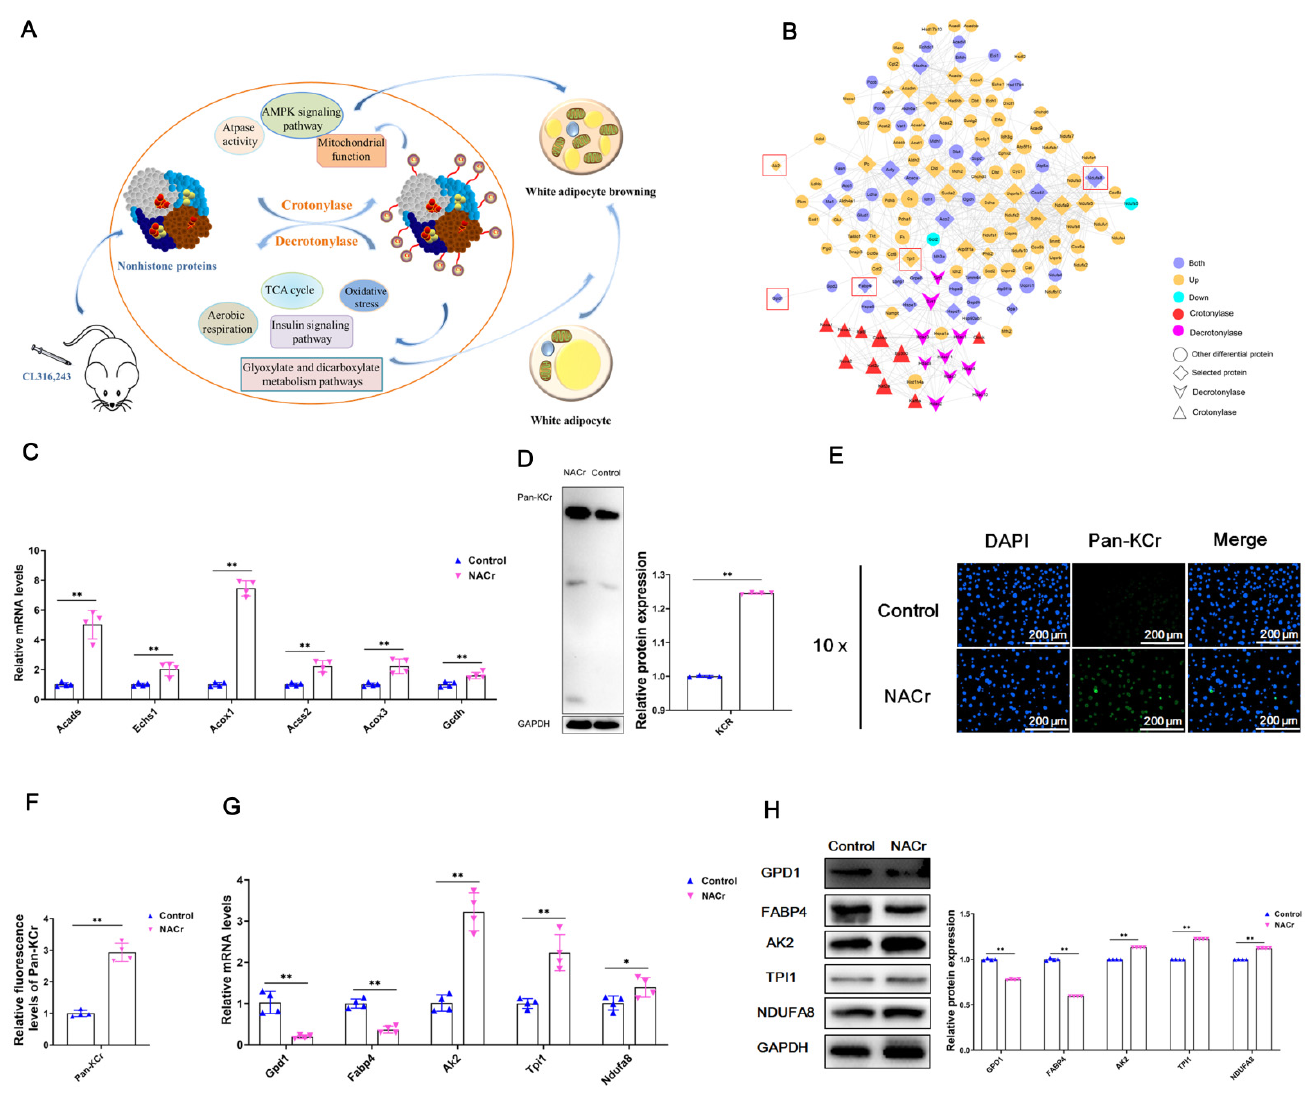
Figure 5. The crotonylation levels of Gpd1 and Fabp4 were downregulated, while the crotonylation levels of Ak2, Tpi1 and Ndufa8 were upregulated. Note: ( A ) Summary figure: after mice were injected with CL316,243, the crotonylation modification of proteins in cells in vivo changed; dynamic regulation of the level of protein crotonylation modification can regulate TCA cycle metabolism, oxidative stress, aerobic respiration, insulin signaling pathway, glyoxylate and dicarboxylic acid metabolism pathway, AMPK signaling pathway, ATPase activity, mitochondrial function, etc., thereby regulating the browning of white fat in the body. ( B ) Interaction network analysis of crotonylated proteins and crotonylation-related enzymes; differentiated and mature adipocytes were treated with 20 mM NACr, and cellular RNA and protein were extracted. ( C ) Relative mRNA expression levels of acylation-related genes after NACr treatment ( n = 4). ( D ) Expression and quantification of Pan-KCr protein after NACr treatment ( n = 4). ( E , F ): Immunofluorescence and quantitative map of Pan-KCr protein after NACr treatment, scale bar: 200 μ m ( n = 4). ( G , H ) The relative mRNA and protein expression levels of Gpd1, Fabp4, Ak2, Tpi1 and Ndufa8 after NACr treatment ( n = 4). Values are mean ± SD compared to the control group, * p < 0.05, ** p < 0.01.